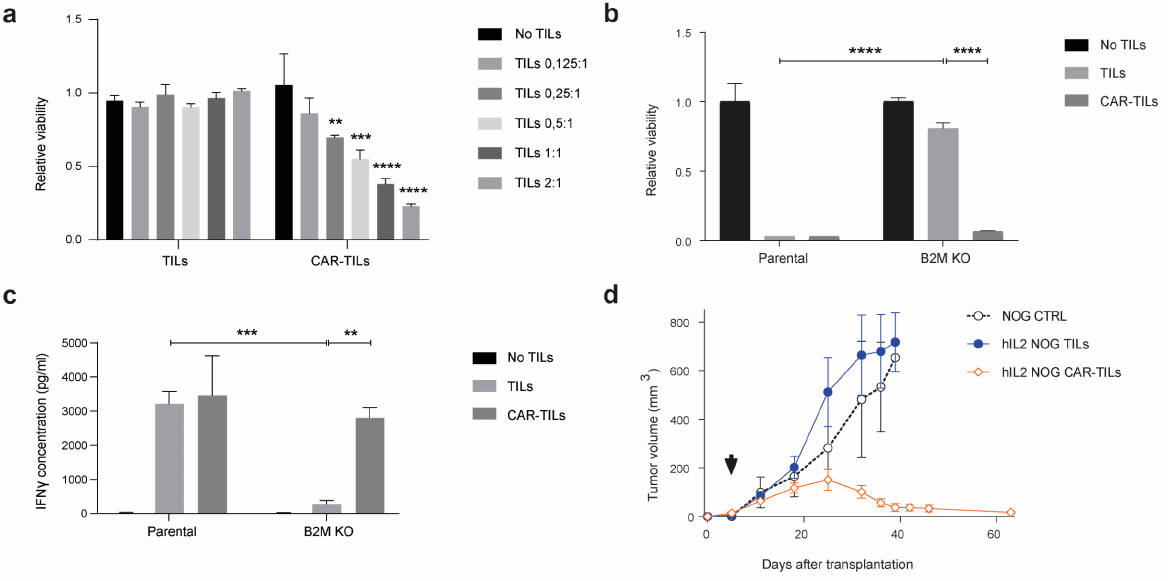
Figure 3. Anti-HER2 CAR-TILs eradicate autologous tumor cells refractory to TCR-mediated cytotoxicity. Parental MM3 melanoma and MM3 cells with CRISPR-Cas9 disruption of β -2-Microglubulin (B2M KO, Supplementary Figure S5) were cultured with autologous TILs or CAR-TILS. ( a , b ) Viability was measured by luciferase activity in melanoma cells after 48 h of co-culture with TILs or mRNA generated ( a ) or virus generated ( b ) CAR-TILs. ( c ) IFN γ was measured in the culture supernatant from the same experiment as in ( b ). ( d ) Mice bearing B2M CRISPR knockout MM3 melanoma cells were treated with PBS ( n = 3), 20 × 10 6 TILs ( n = 3), or 20 × 10 6 CAR-TILs ( n = 3). Arrow indicates treatment start. Data are presented as mean ± standard error of the mean. p values are represented as ** p < 0.01, *** p < 0.001, and **** p <